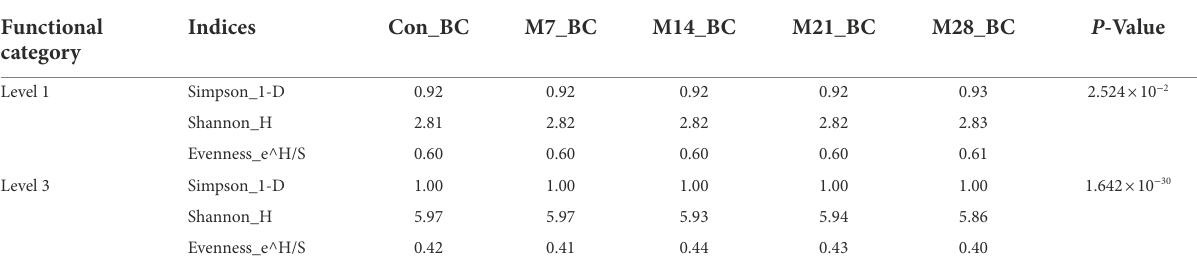
TABLE 4 The estimation of alpha diversity indices of functional categories of microbial community in caecum digesta samples from broiler chickens fed with diets containing different levels of marama bean meal. Functional